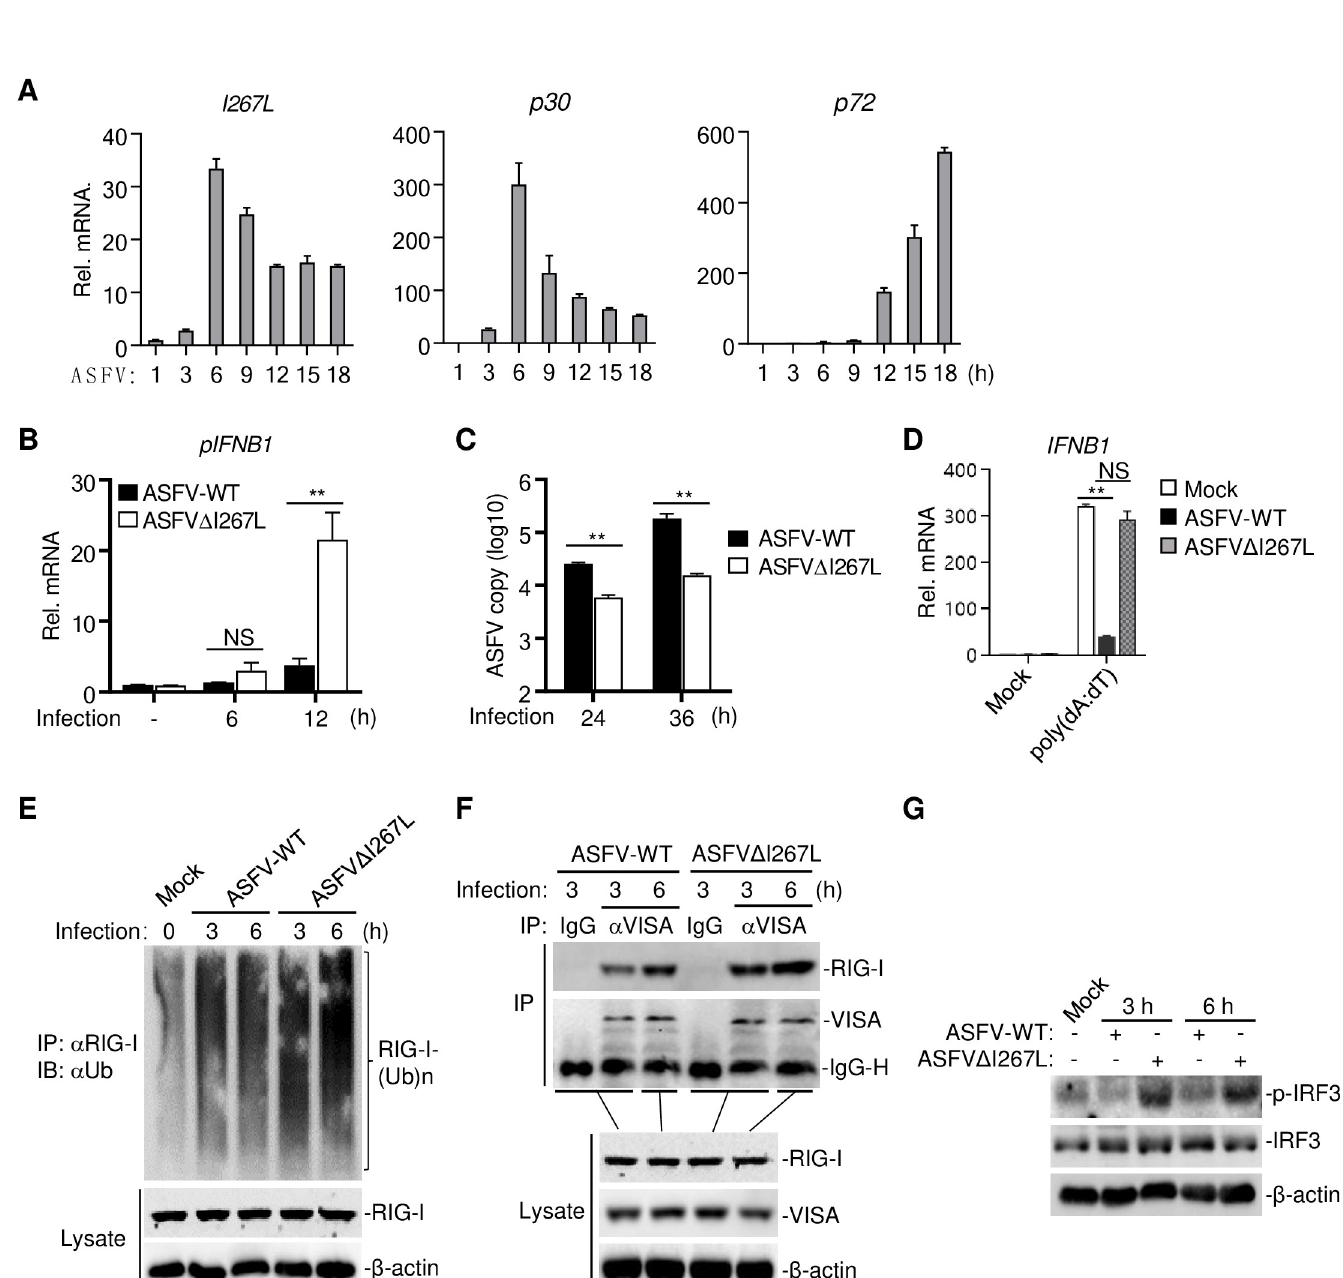
Fig 6. Deficiency of I267L attenuates the ability of ASFV to antagonize innate immune responses. ( A ) Determining the expression level of I267L during ASFV infection by RT-qPCR. The p30 and p72 are shown as indicators of early gene and late gene respectively. ( B ) PAMs (1 × 10 6 ) were infected by ASFV-WT or ASFV Δ I267L (MOI = 0.1) for 6 hours or 12 hours before RT-qPCR were performed. ( C ) PAMs (1 × 10 6 ) were infected by ASFV-WT or ASFV Δ I267L (MOI = 0.1) for 24 hours or 36 hours. Virus DNA was extracted from the cells to determine the viral DNA copies of p72 by qPCR. ( D ) PAMs (2 × 10 6 ) were uninfected or infected with ASFV-WT or ASFV Δ I267L (MOI = 0.1) for 6 hours, and then were stimulated with transfected poly(dA:dT) (1 μ g/ml) for 4 hours before RT-qPCR were performed. (E ) PAMs (2 × 10 7 ) were uninfected or infected with ASFV-WT or ASFV Δ I267L (MOI = 0.1) for the indicated times. Immunoprecipitation and immunoblotting were performed with the indicated antibodies (2 μ g anti-RIG-I antibody was used for each immunoprecipitation). ( F ) PAMs (2x10 7 ) were uninfected or infected with ASFV-WT or ASFV Δ I267L (MOI = 0.1) for the indicated times. Immunoprecipitation and immunoblotting were performed with the indicated antibodies (2 μ g IgG control or anti- RIG-I antibody was used for each immunoprecipitation). IgG-H indicates the heavy chain of IgG. ( G ) PAMs (5 × 10 6 ) were uninfected or infected with ASFV-WT or ASFV Δ I267L (MOI = 0.1) for the indicated times. Cells were lysed and subjected to Western blot analysis for examination of the phosphorylation and expression of IRF3. The β -actin were used as loading